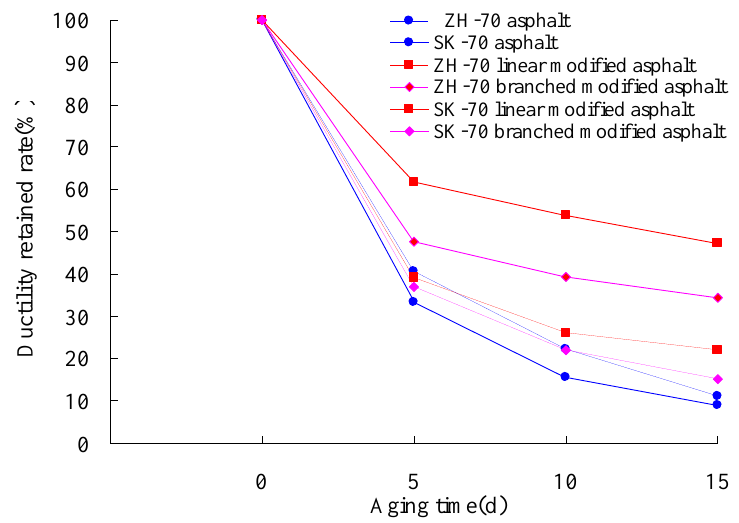
Figure 7. Ductility retained rates and aging times for different asphalts.